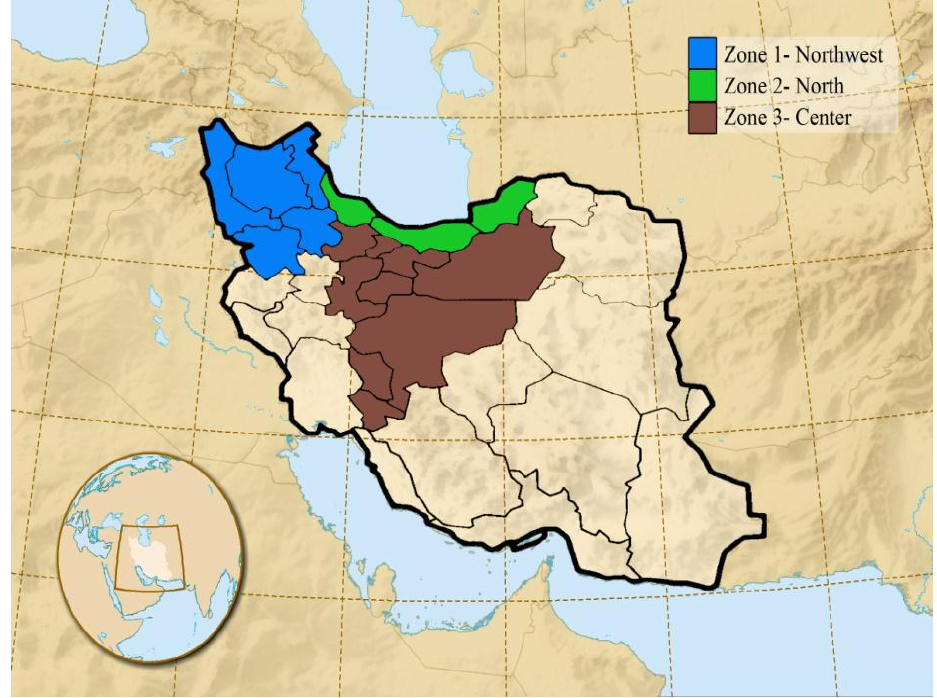
Figure 1. Classification of three study zones according to climate conditions in Iran.